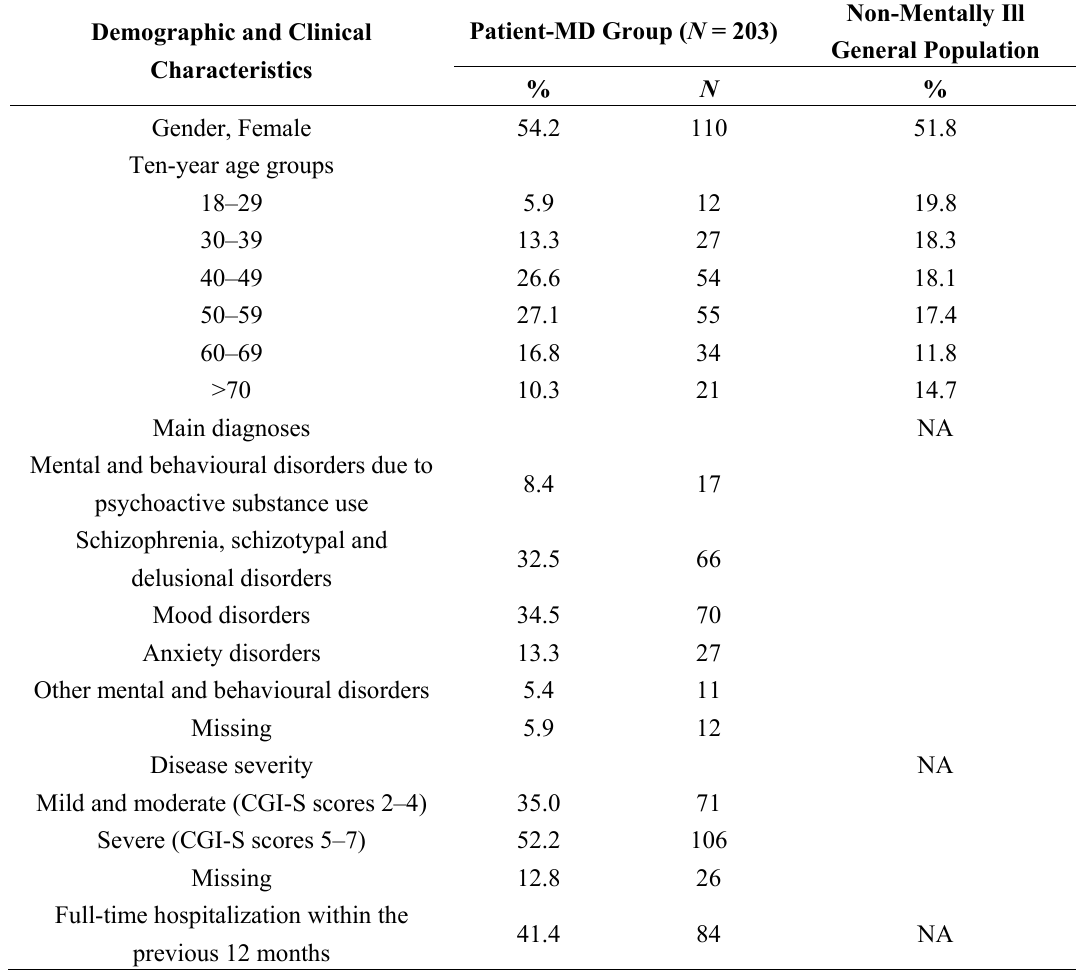
Table 1. Demographic and clinical characteristics of the studied populations. Demographic and